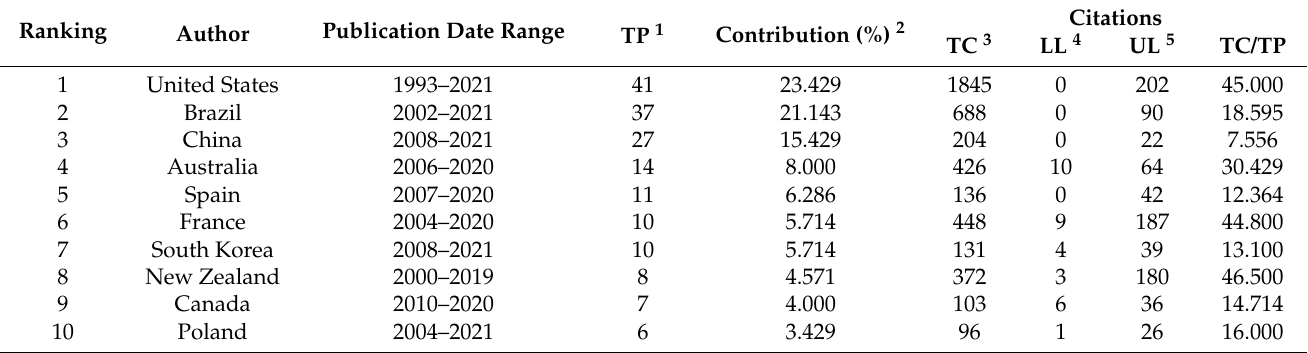
Table 2. Countries with more participation in research on the role of causal genes in meat